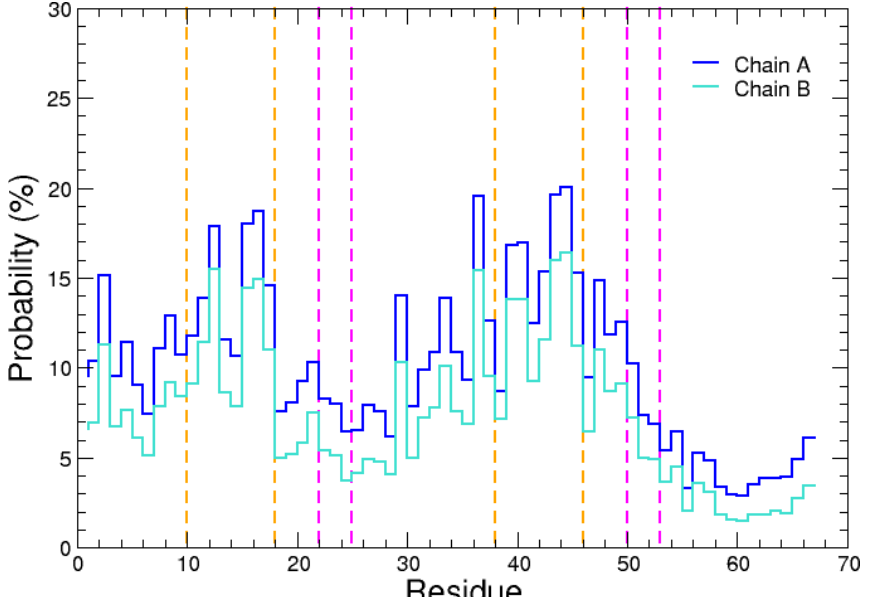
Figure 9. Probability of the N-WASP domain V residues to be distant by less than 4 Å from actin dimer. Orange and magenta dashed lines indicate the N-WASP regions in α -helix (as revealed by the X-ray structure 2VCP [27]) and the consensus sequences “LKKV” [14,31],